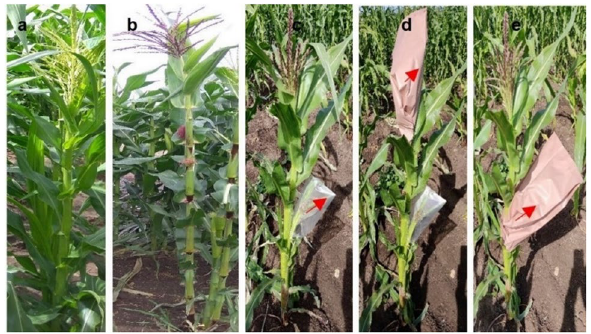
Figure 5. Parental plants: (a) white shrunken2 super-sweetcorn accession, ‘Tims-white’, ( b) purple-pericarp Peruvian maize accession, ‘Costa Rica’. Pollination and crossing: (c) covered ear, ( d) covered tassels (and ear), ( e) bagging after